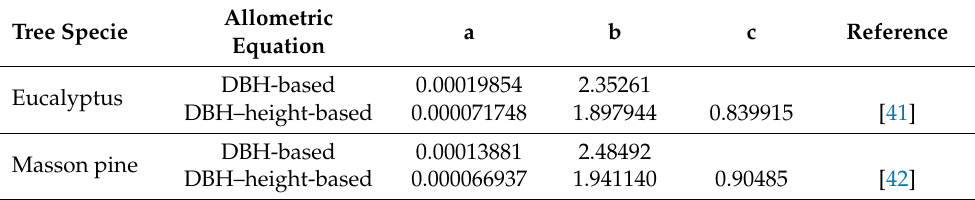
Table 2. Coefficients of the allometric equations for different tree species. Tree Specie